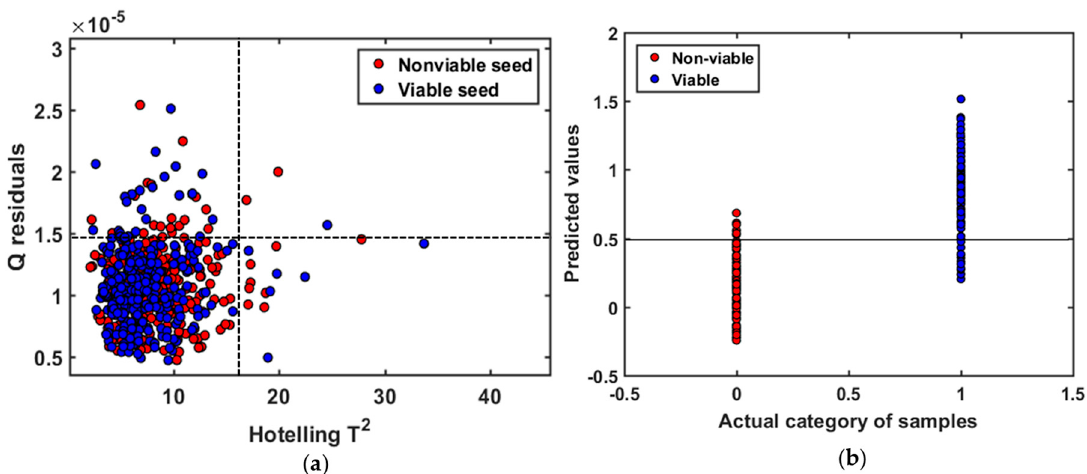
Figure 4. ( a ) Plot of Q residuals versus Hoteling’s T2. Nonviable seed samples are colored in ‘red’ and viable samples in ‘blue’ for the general model; ( b ) classification result of the validation set with Savitzsky-Golay 1st derivative preprocessing at 0.5 threshold value. Table 1. Seed viability detection in prediction for the general model.